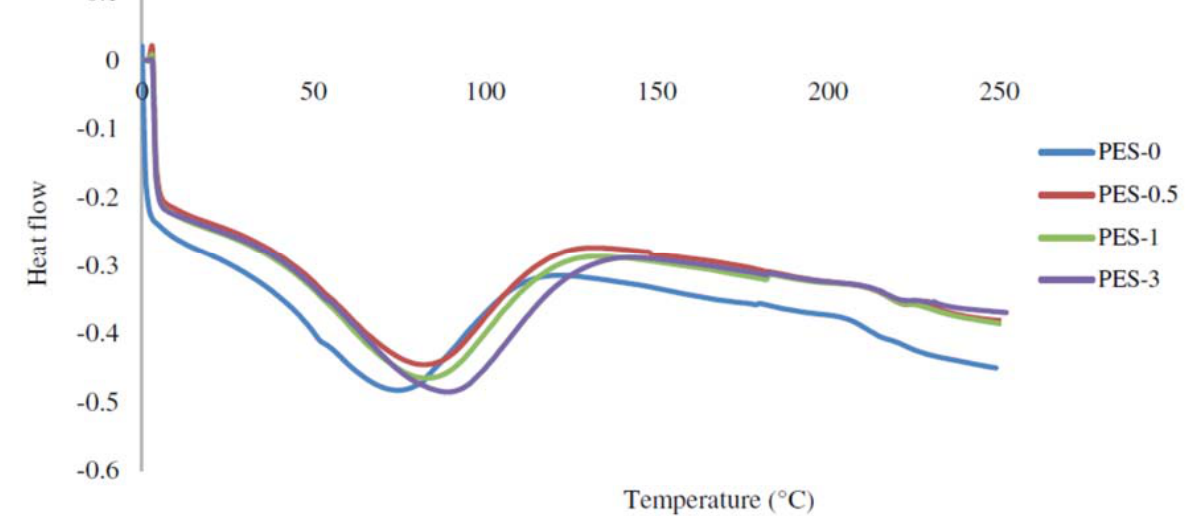
Figure 3. DSC thermograms of PES membranes embedded with different modified microcrystalline. Cellulose (MMCC) contents. Reprinted from [16] with permission of